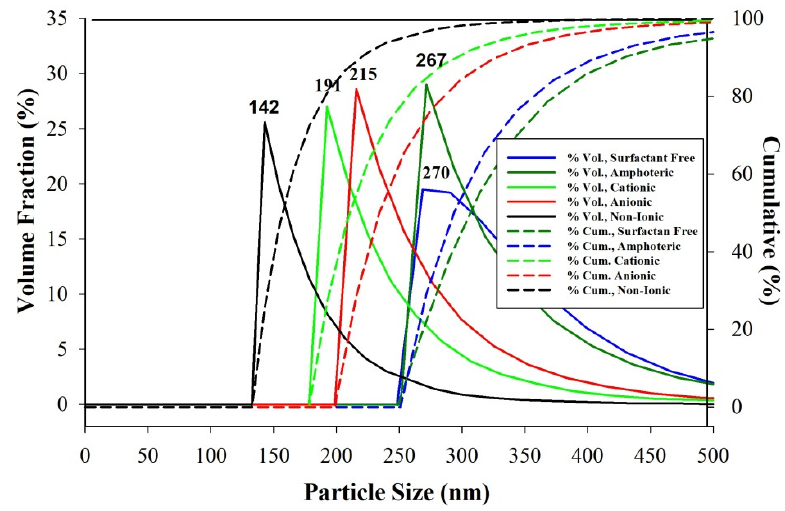
Figure 9. Effect of surfactant type on particle size distribution of BaFe 11.2 Mg 0.4 Al 0.4 O 19 .